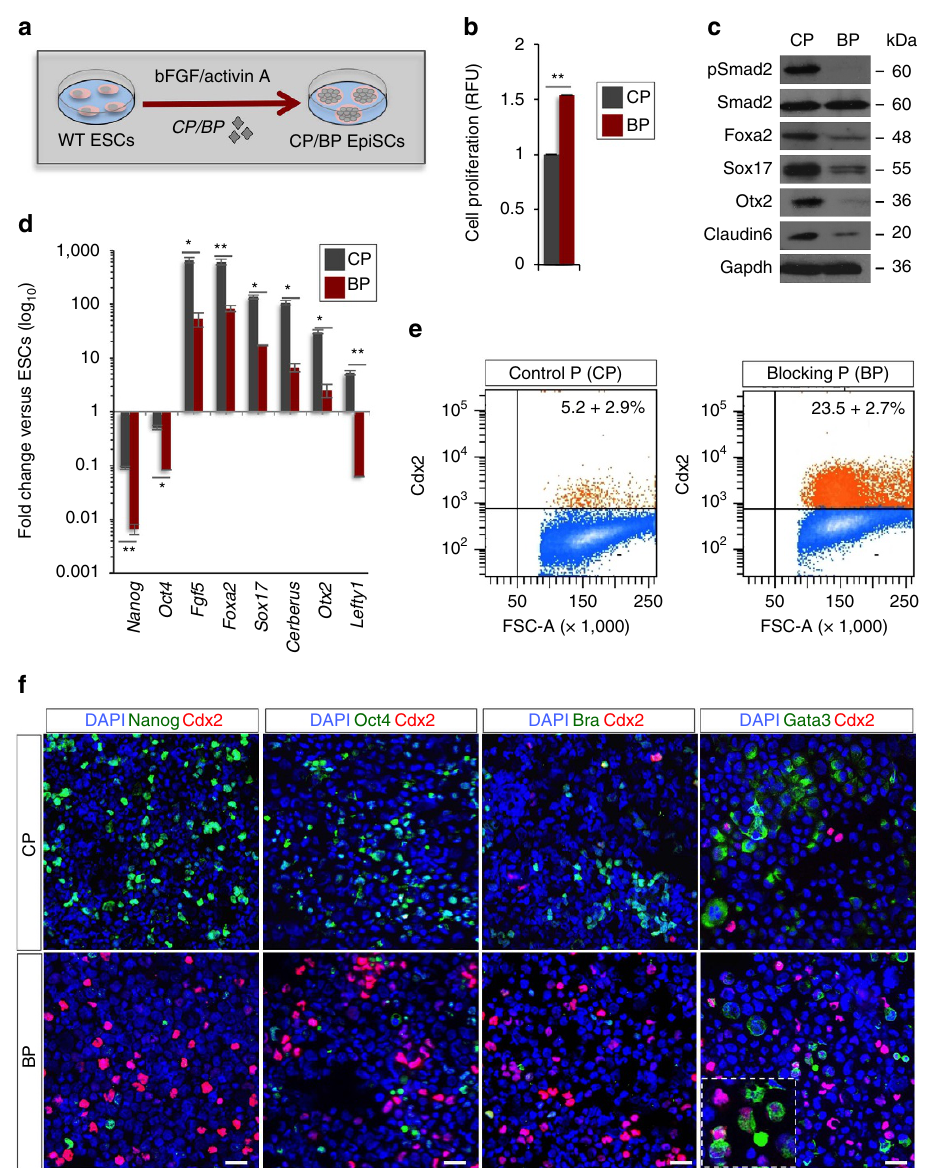
Figure 7 | Pharmacological inhibition of Cripto signalling prevents ESC - EpiSC transition. ( a ) Schematic representation of the experimental procedure. ( b ) Proliferation of CP/BP-treated cells measured by the CyQuant assay and expressed as RFU. ( c ) Western blot analysis of pSmad2, Foxa2, Sox17, Otx2 and Claudin6 in CP/BP-treated F/A cells. Smad2 and Gapdh were used as a loading control. ( d ) Gene expression profiles of selected markers in CP/BP-treated F/A EpiSCs. Data are shown as fold change compared with ESCs (serum/LIF) after normalization to Gapdh and are mean ± s.e.m. ( n ¼ 3; * P o 0.01 and ** P o 0.005). ( e ) FACS quantification of Cdx2 þ cells in CP/BP-treated cultures. Data are mean are mean ± s.e.m. ( n ¼ 3). ( f ) Representative pictures of Nanog/Cdx2, Oct4/Cdx2, Bra/Cdx2 and Gata3/Cdx2 double immunostaining of CP/BP-treated cytospinned cells (scale bar, 75 m m). Inserts are higher magnification images of selected areas. Nuclei were stained with 4,6-diamidino-2-phenylindole